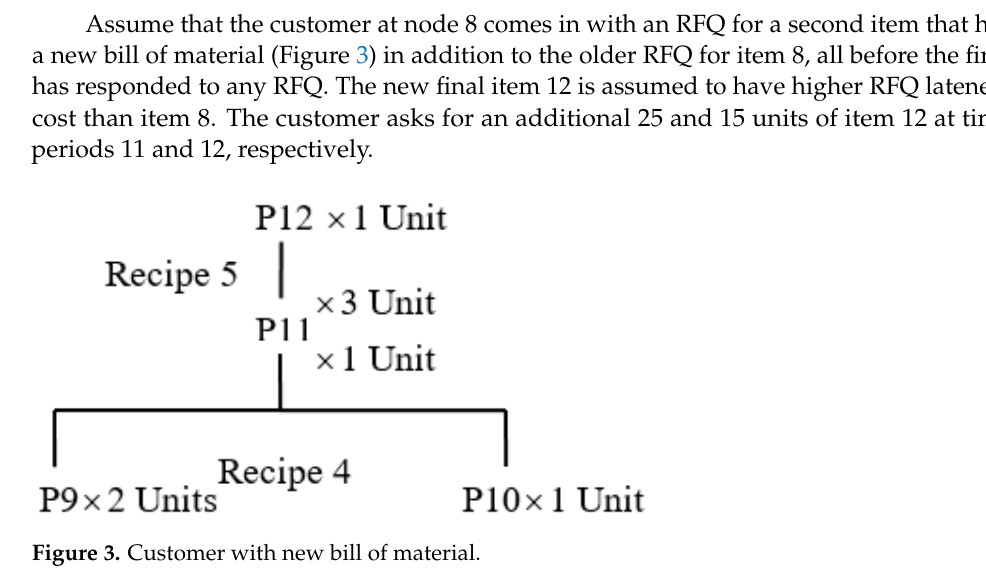
Figure 3. Customer with new bill of